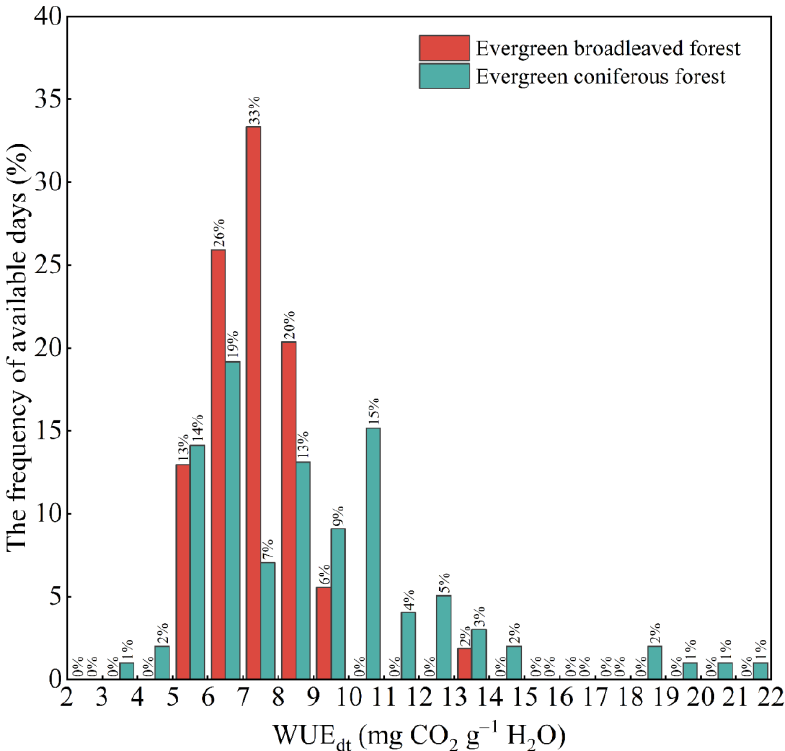
Figure 3. Histogram of WUE dt in the broadleaved forest at Dinghushan and in the coniferous forest at Qianyanzhou on summer no-rain days over 2003 – 2005. Table 2. The mean and standard deviation of WUE dt and diurnal C – W coupling (correlation coeffi- cient r between hourly GPP and ET) in the broadleaved forest at Dinghushan and in the coniferous forest at Qianyanzhou on summer no-rain days over 2003 – 2005. The form of values in the table is mean ± standard deviation.